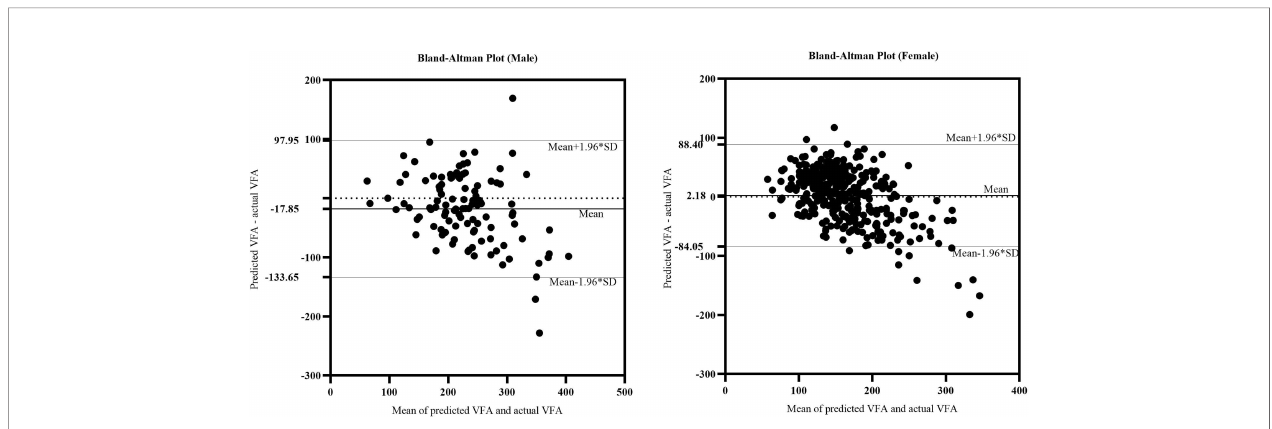
FIGURE 3 | The Bland-Altman plot of actual CAP and predicted CAP. The upper and lower horizontal solid lines in the picture represented the 95% limits of agreement. The middle horizontal solid line in the middle represented the average value of the difference. The horizontal dotted line indicated the position where the average value of the difference was zero.